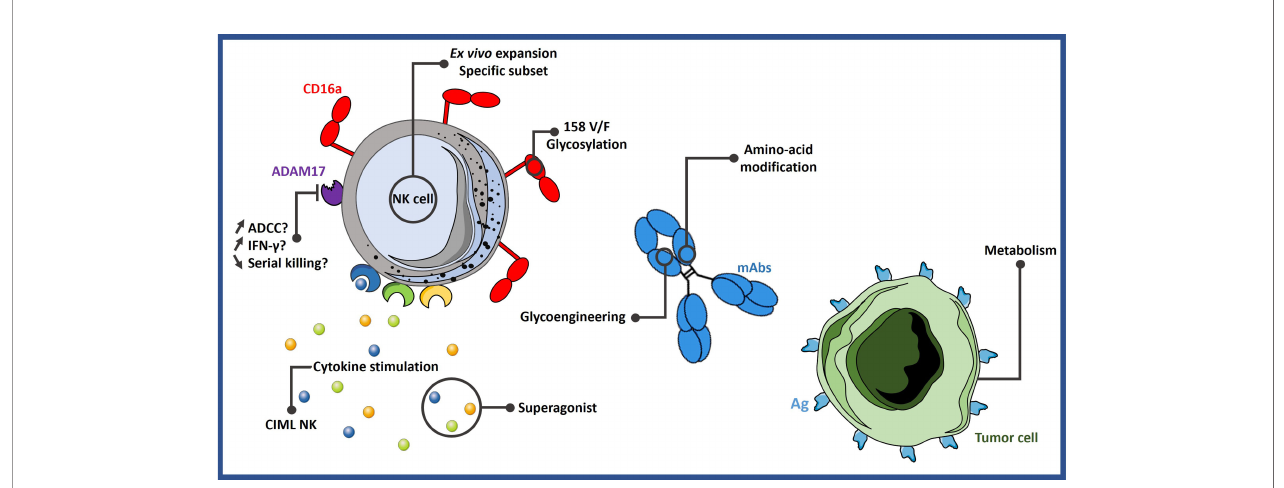
FIGURE 1 | Different strategies to improve ADCC. NK cell-mediated ADCC can be enhanced by expanding them with speci fi c protocols or by stimulating them with certain cytokine cocktails. It could be possible to select more potent NK cell subsets based on their phenotype or genotype. Engineering mAbs are also an ef fi cient way to increase ADCC activity. Lastly, tumor cells can be sensitized to NK cell activity by modifying their metabolism. ADCC, antibody-dependent cell-mediated cytotoxicity; Ag, antigen; CIML NK, memory-like natural killer cells; mAbs, monoclonal